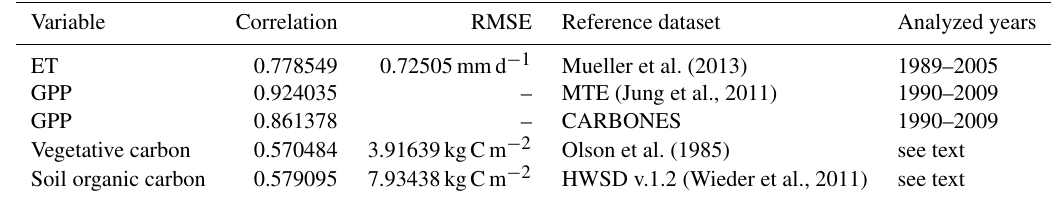
Table 3. RMSEs and correlations between multiyear annual means of SEDGES variables and those for reference datasets